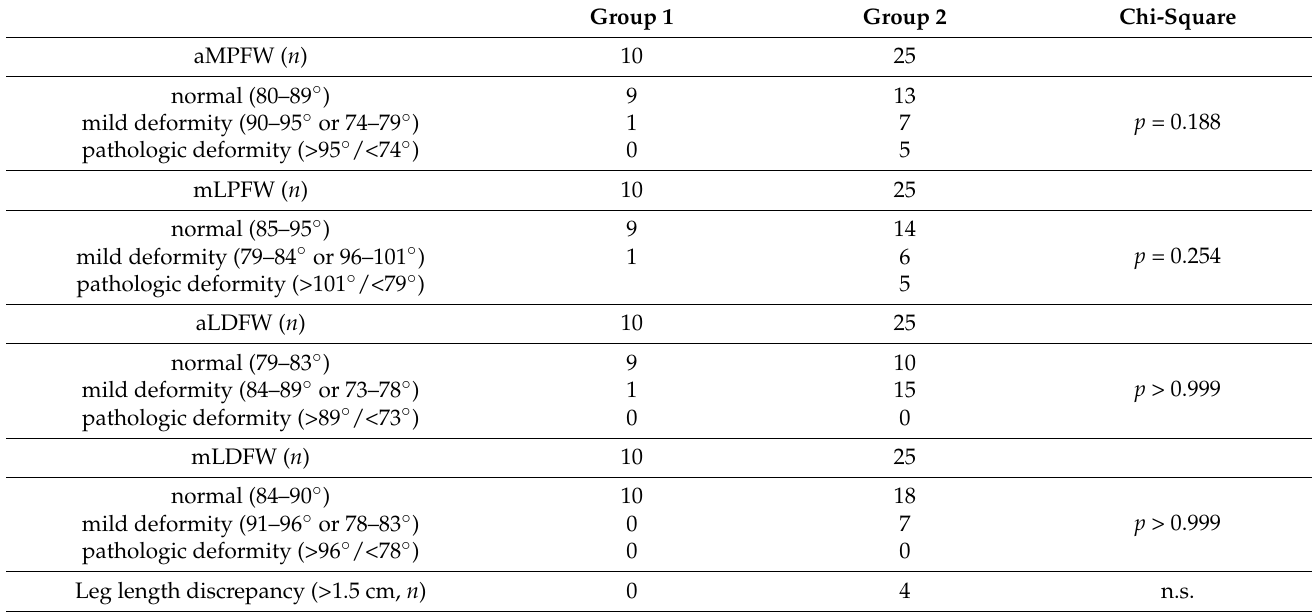
Table 4. Results of the measurement of the mechanical and anatomical axes and joint angles on full leg radiographs at latest follow